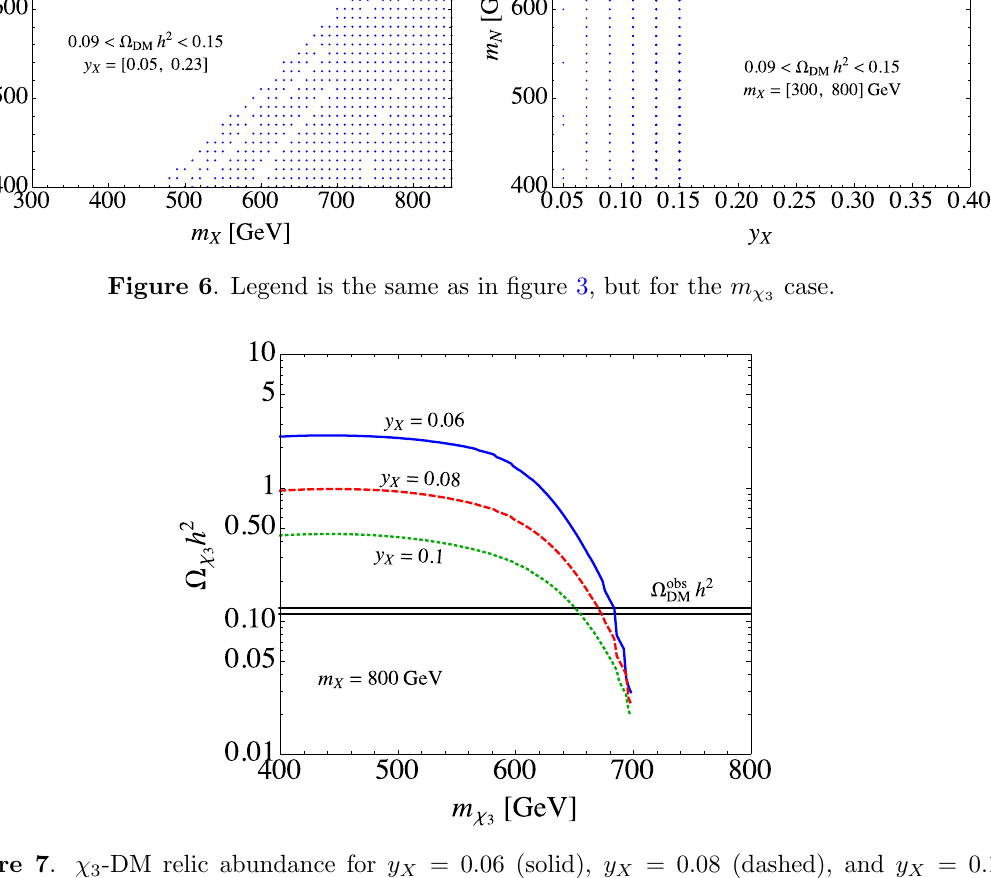
h 2 with 3 (cid:27) DM